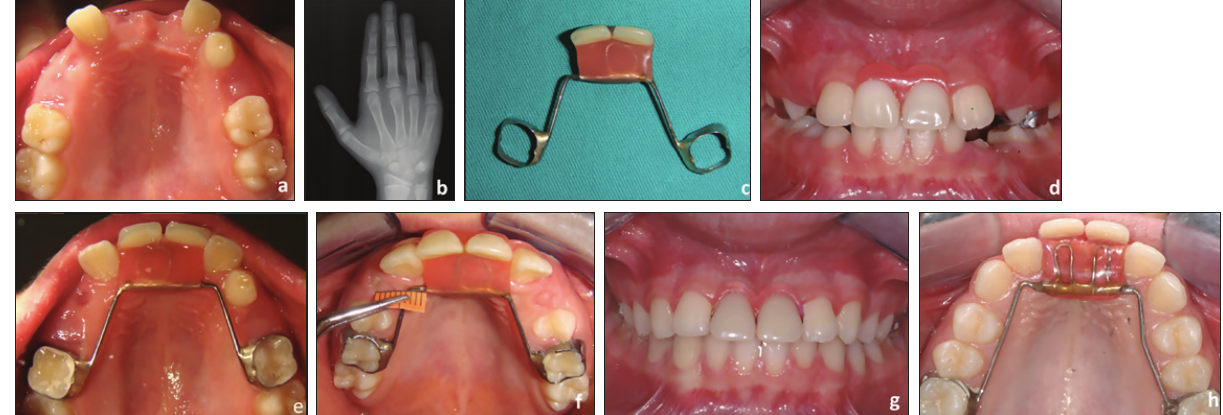
Figure 3. The treatment progress of Patient 2: a) pretreatment (intraoral occlusal view); b) hand-wrist radiographs showed that the patient was at MP3= stage (epiphysis of the middle phalanx of the middle finger was found to be as wide as the diaphysis); c) space maintainer before insertion; d) appliance in place (intraoral frontal view); e) appliance in place (intraoral occlusal view); f) at 18-month clinical examination, 1.5 mm of expansion was observed on the sliding wire of the space maintainer; g and h) at 24-month follow-up, a new appliance was